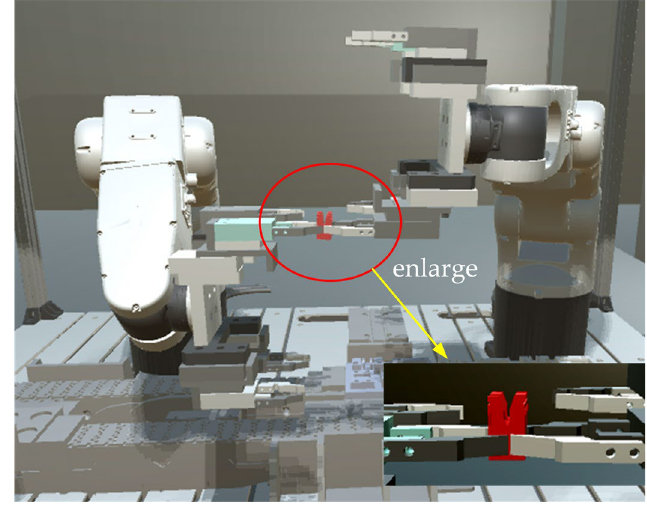
Figure 16. Two-arm cooperation robots working together to grip parts.